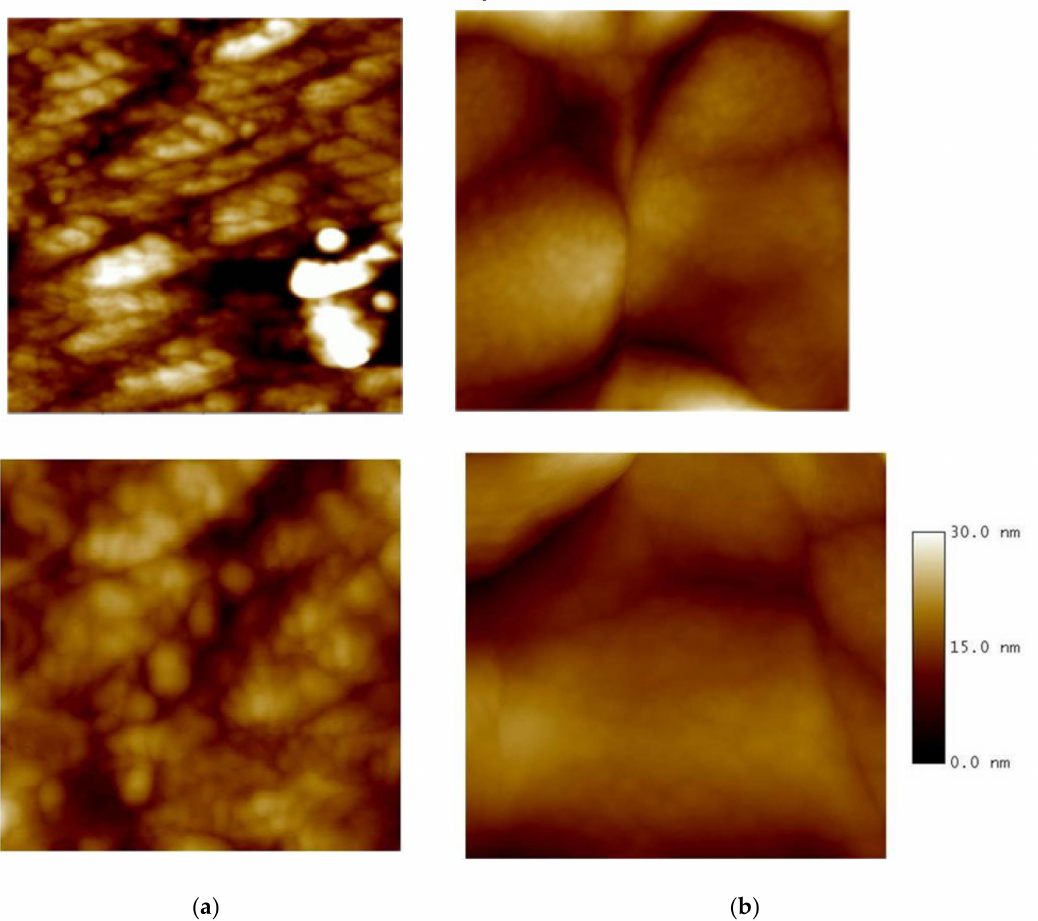
Figure 9. A comparison between AFM topography images of oligo-( R )-Naph 2 T 4 films grown in CH 2 Cl 2 ( a ) and in CH 3 CN ( b ). Scan areas: both images on first row: 1 × 1 µ m 2 ; both images on second row: 500 × 500 nm 2 . Vertical (color) scale: 30